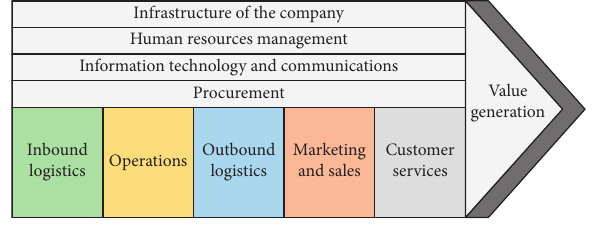
Figure 1: Value chain structure